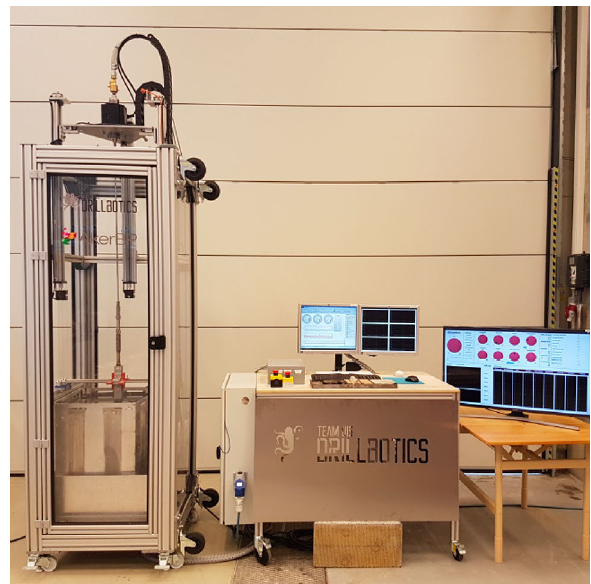
Fig. 1 Laboratory rig test